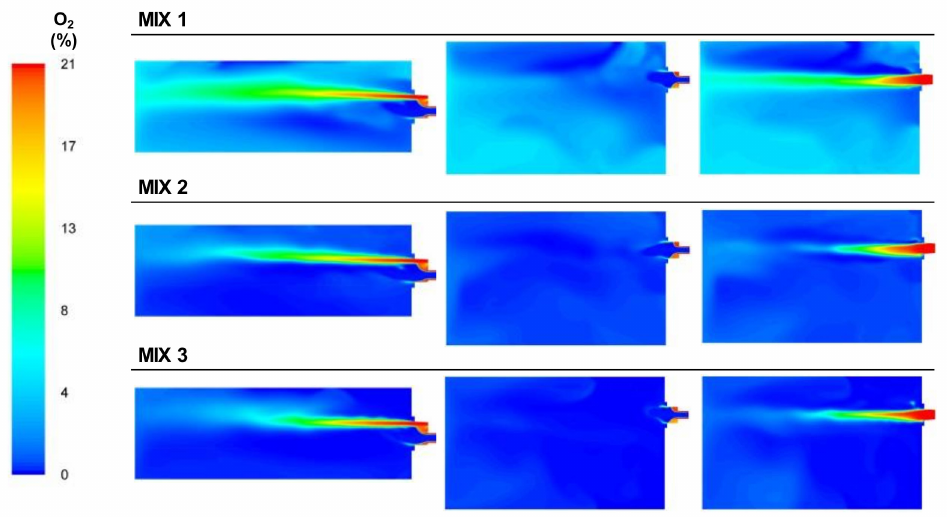
Figure 20. Contour plots of oxygen concentrations for the BFG/NG mixture cases in the XZ1, XY1, and XY2